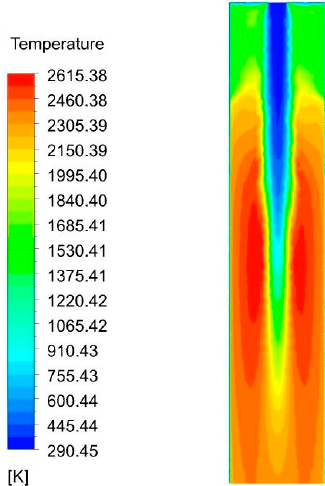
Figure 5. Temperature contour on the symmetric surface.